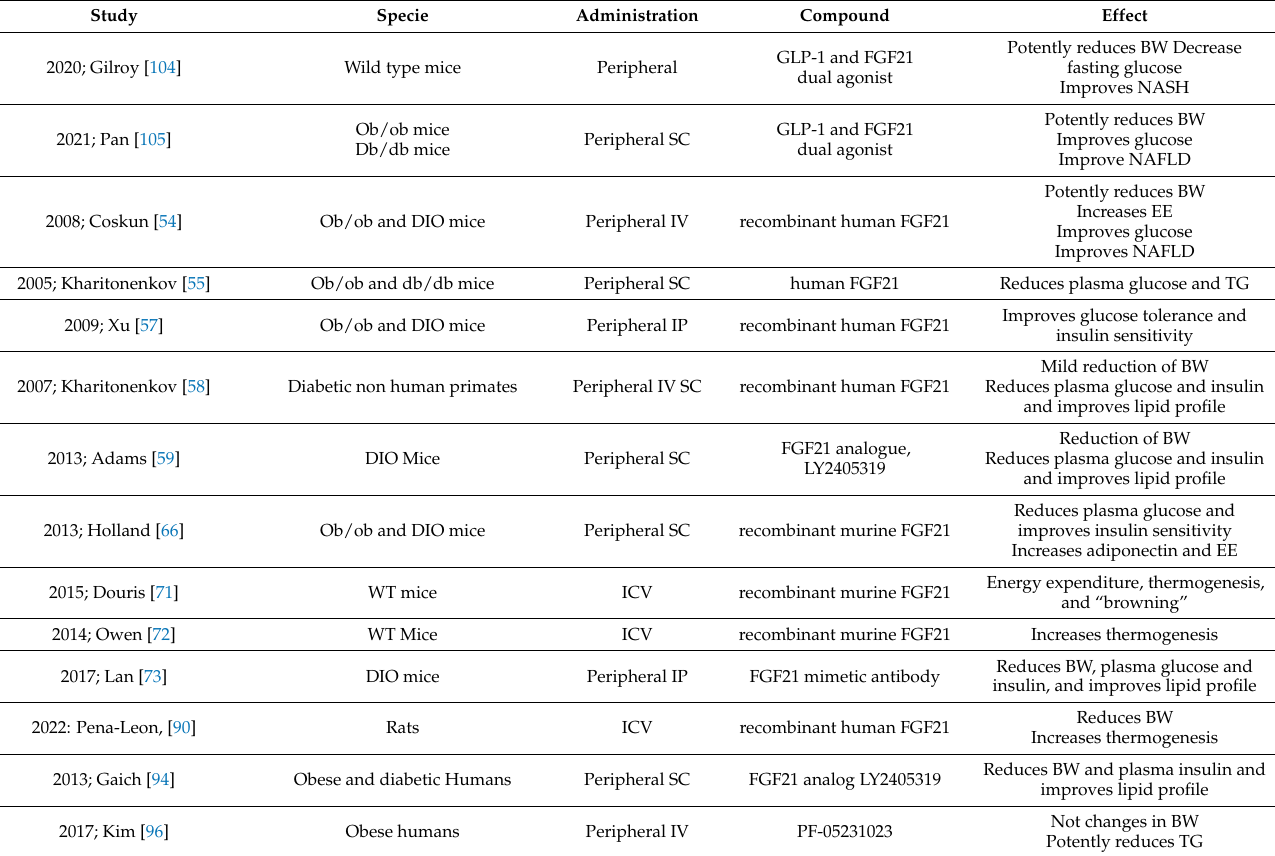
Table 1. Metabolic actions of FGF21 mimetics or FGF21 signaling activation compounds: BW: body weight; db/db mice: mice lacking leptin receptor; DIO: diet induced obesity; EE: energy expenditure; FGF21: Fibroblast growth hormone 21; GLP-1: Glucagon like peptide-1; ICV: intracerebroventricular; ip: intraperitoneal; iv: intravenous; NAFLD: non-alcoholic fatty liver disease; NASH: